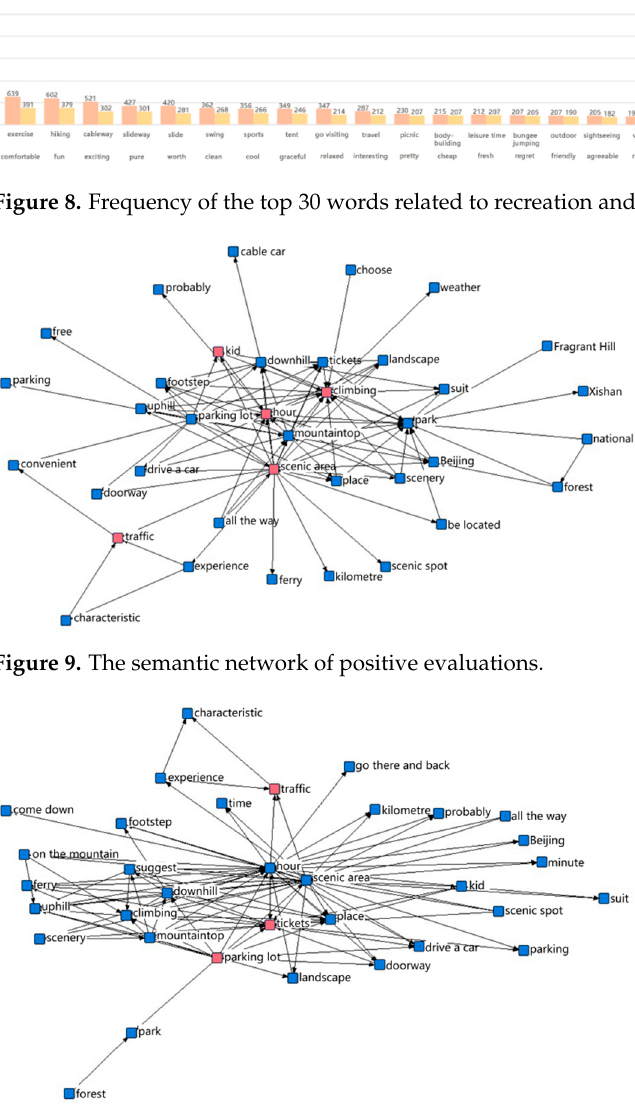
Figure 10. The semantic network of negative evaluations.